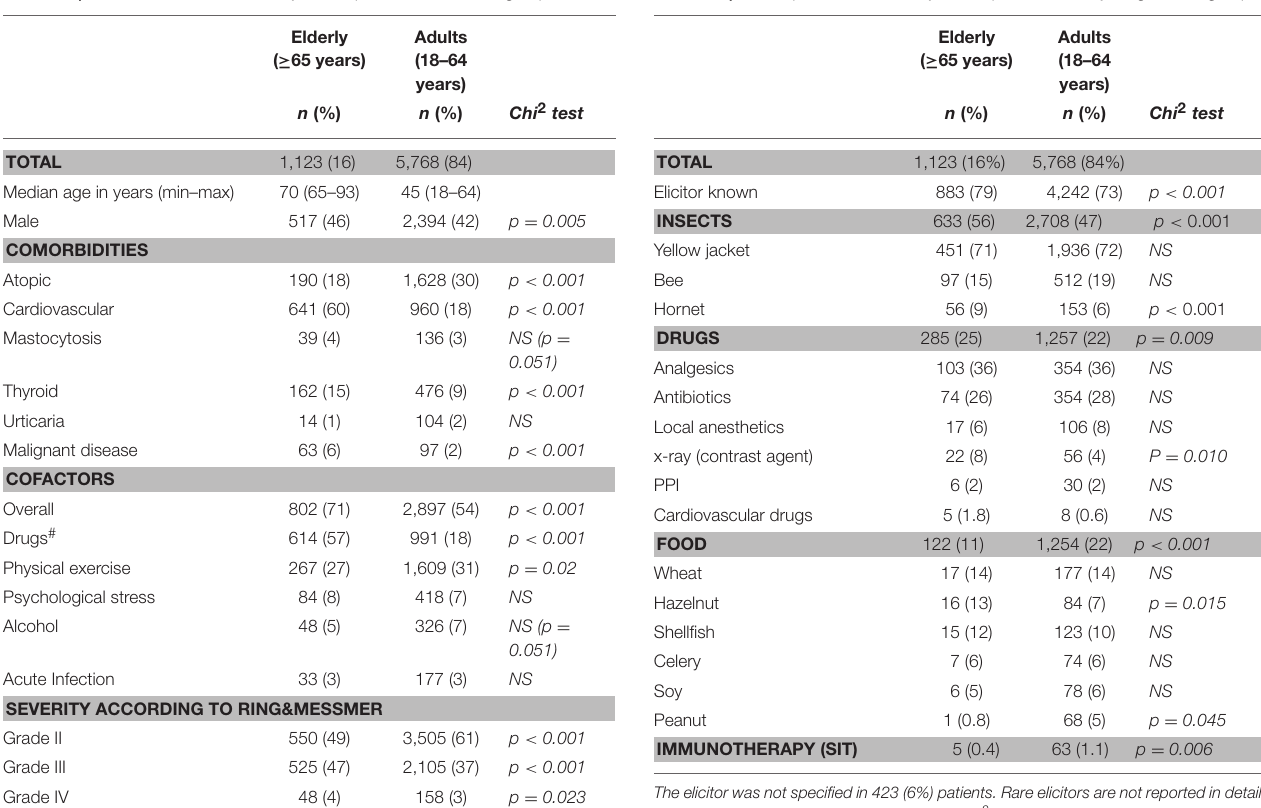
TABLE 1 | Characteristics of the elderly in comparison to the adult group. TABLE 2 | Elicitor profile in the elderly in comparison to the younger adult